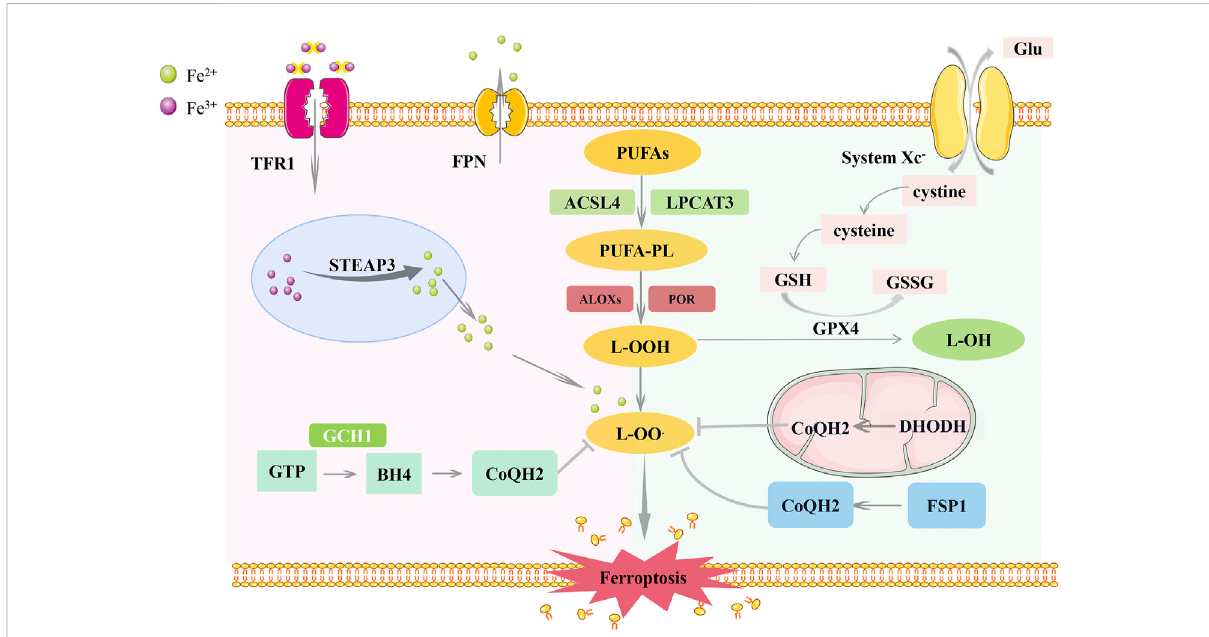
FIGURE 1 Regulatorypathwaysofferroptosis.Ferroptosisisco-regulated byironmetabolism,lipidmetabolism,andantioxidantsystems.Theinhibitionof lipid peroxidation is mainly mediated by the SLC7A11-GSH-GPX4 pathway, FSP1-CoQ10-NAD (P)H pathway, GCH1-BH4-DHFR pathway and DHO- DHODH-OA pathway. Among them, the FSP1 pathway exists in the cytoplasm, the DHODH pathway exists in the mitochondria, and the GPX4pathwayplaysaroleinboth. SLC7A11, Cystine/glutamateantiportersolutecarrierfamilysevenmember11;GPX4,glutathione peroxidase 4;GSH, glutathione;FSP1, ferroptosis suppressorprotein1;GGH1,GTPCyclohydrolase1; BH4, tetrahydrobiopterin;DHFR,dihydrofolate reductase; DHO, dehydrogenation of dihydroorotate; DHODH, Dihydroorotate Dehydrogenase; OA, orotate; ACSL4, acyl-CoA synthetase long-chain family member 4; LPCAT3, lysophosphatidylcholine acyltransferase 3; ALOXs, arachidonate lipoxygenases; POR, cytochrome P450 oxidoreductase.